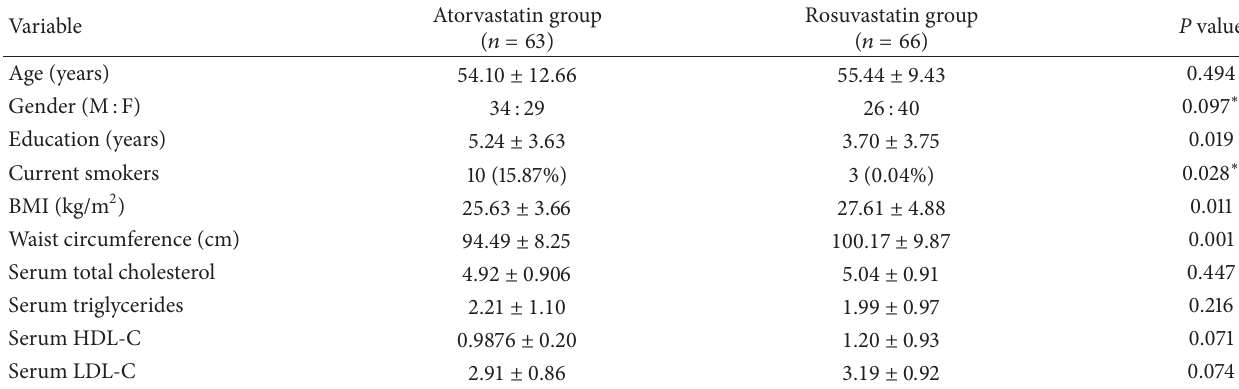
Table 1: Baseline characteristics of study population.